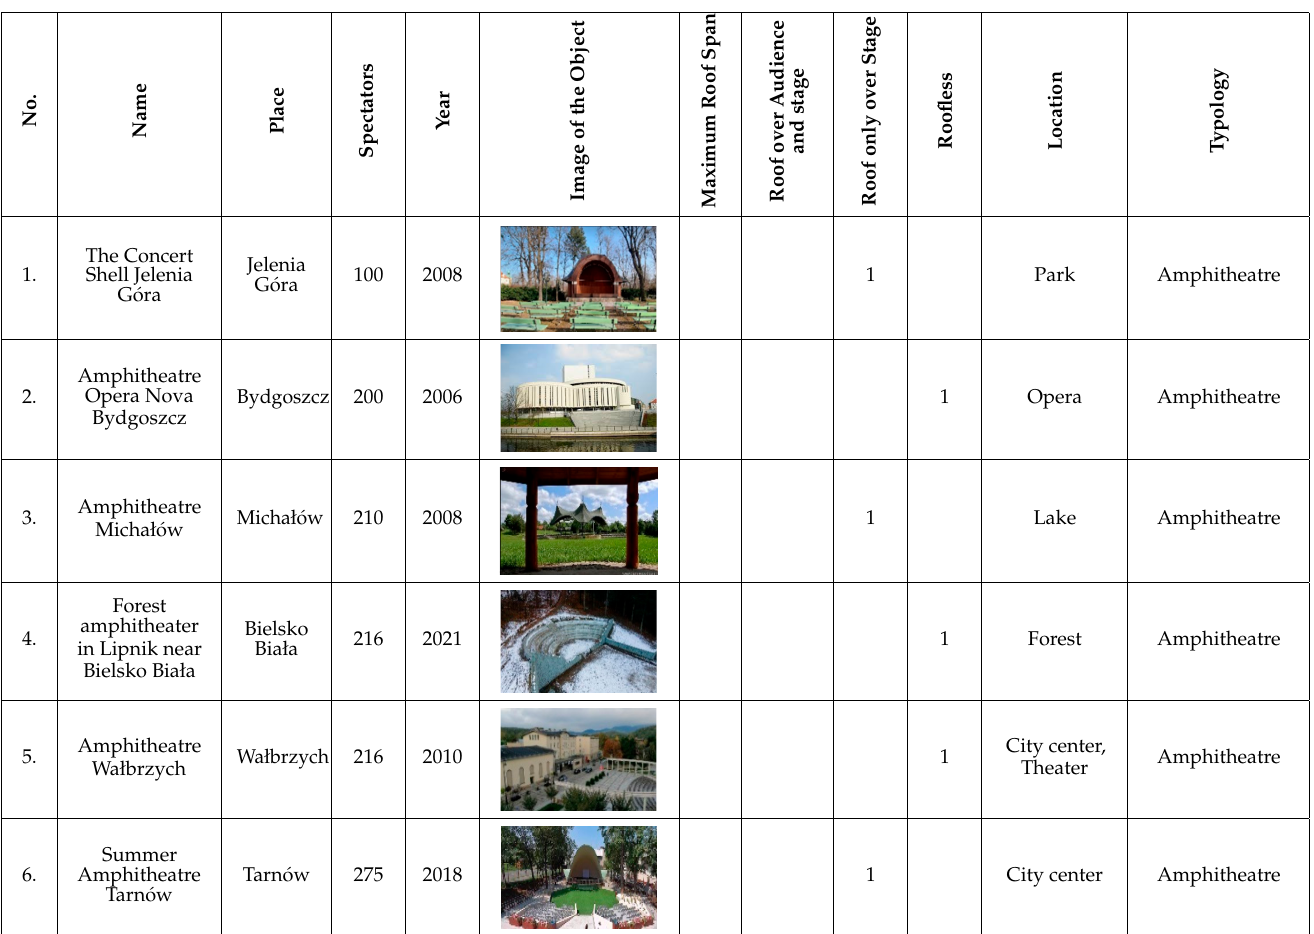
Table 1. Fifty-seven amphitheaters in Poland ordered by number of spectators. Number 1 in the cell means that the described factor exists. Author’s research. Amphitheaters are shown on the map in Figure 5 following the numbers in column one.